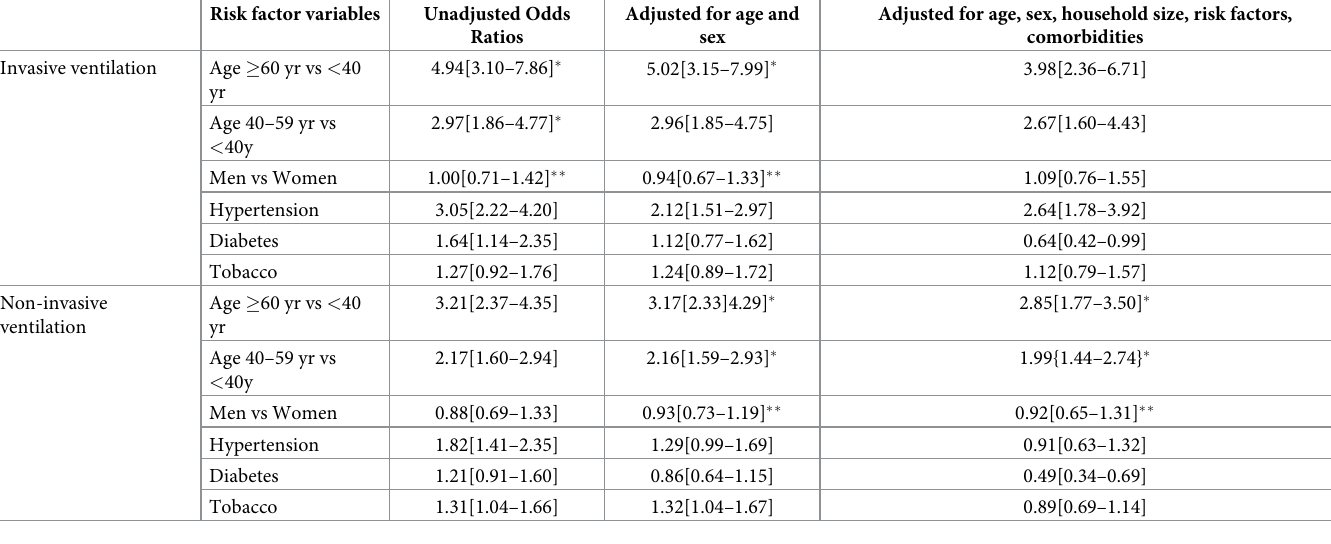
Table 7. Univariate and multivariate logistic regression analyses (odds ratio and 95% confidence intervals) for secondary outcomes in various cardiovascular risk factor groups.